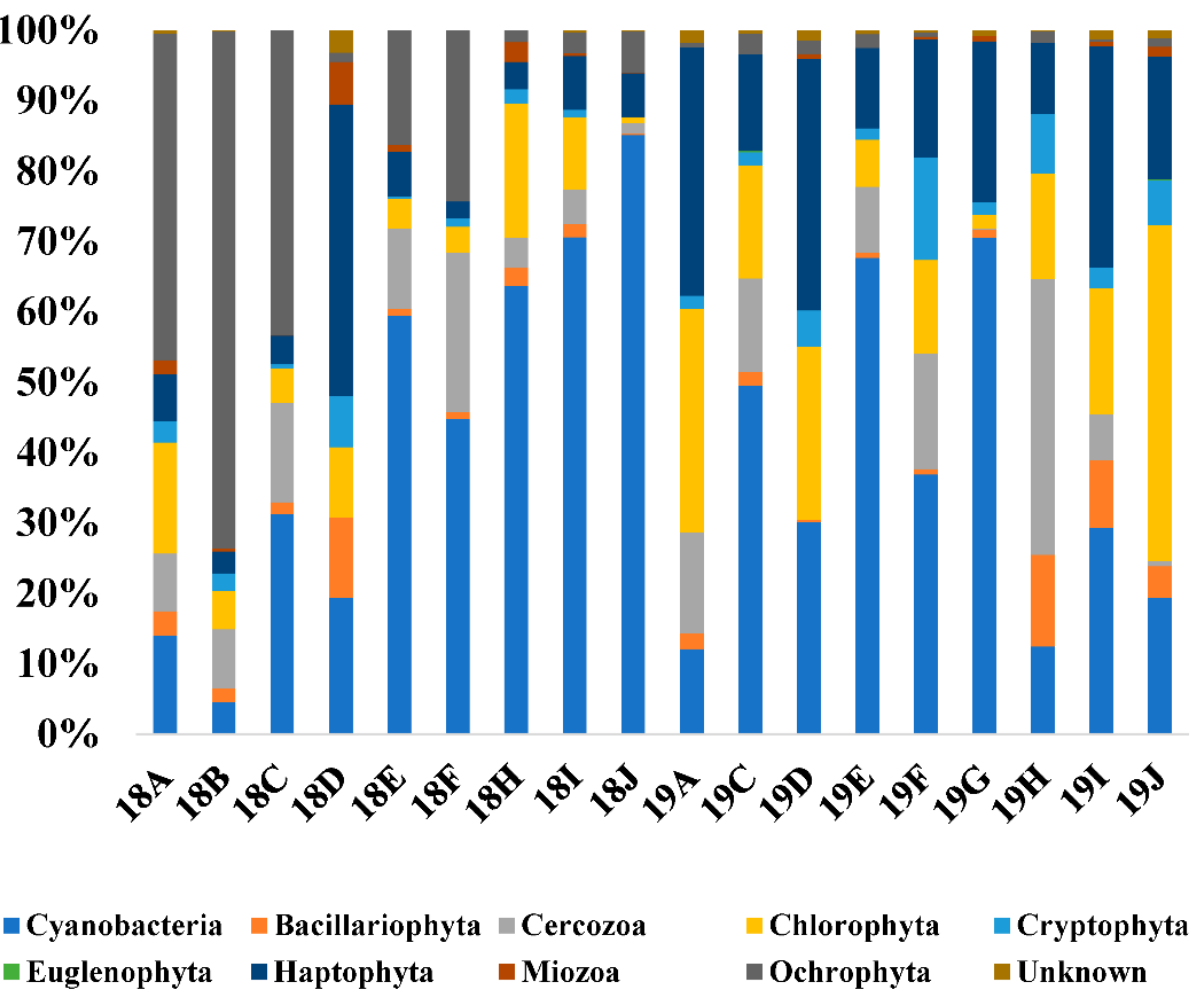
Figure 7. Photosynthetic phytoplankton community structures of samples. Relative abundances of the dominant groups at the phylum level.